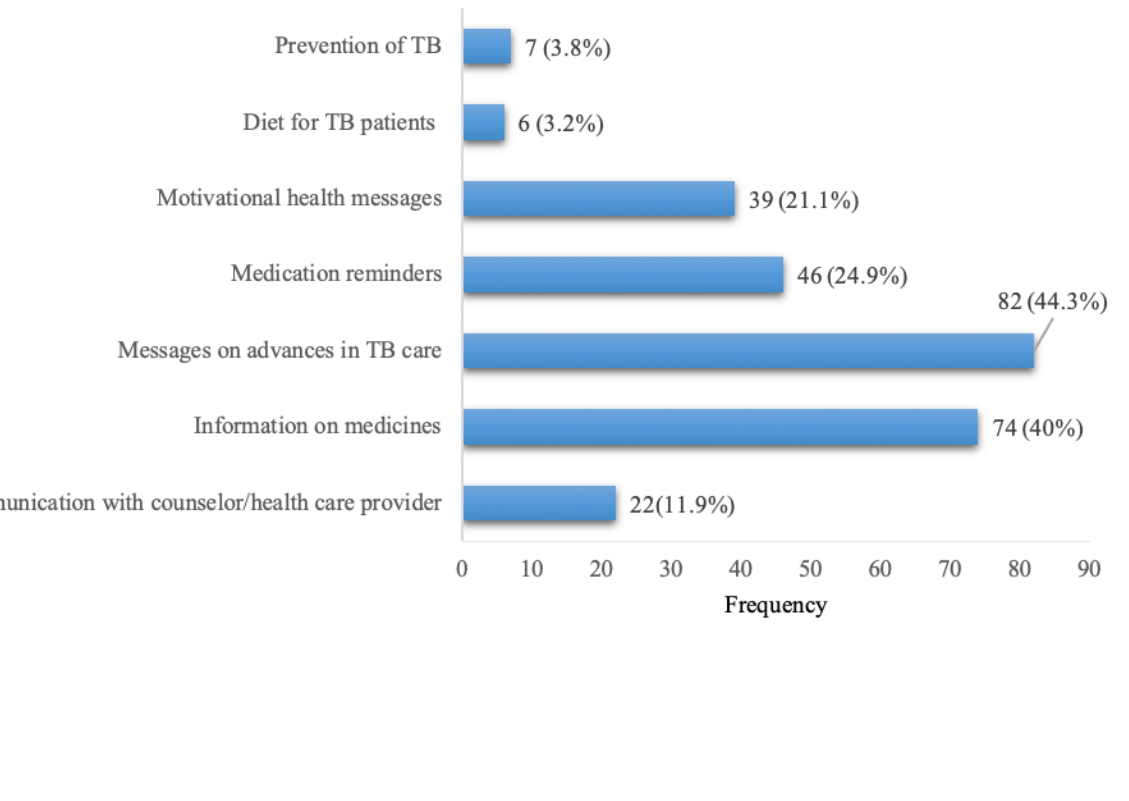
Figure 1. Type of health information requested over mobile phone (N=185). TB: